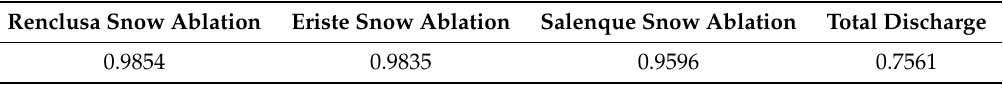
Figure 6. Observedand simulatedsnowcoverafter theevent. ( a )Landsatimage 26June2013; ( b )Simulated snow water equivalent (SWE) on the same day. Table 3. Nash-Sutcliffe efficiency values for the measured and simulated snow ablation at three snow